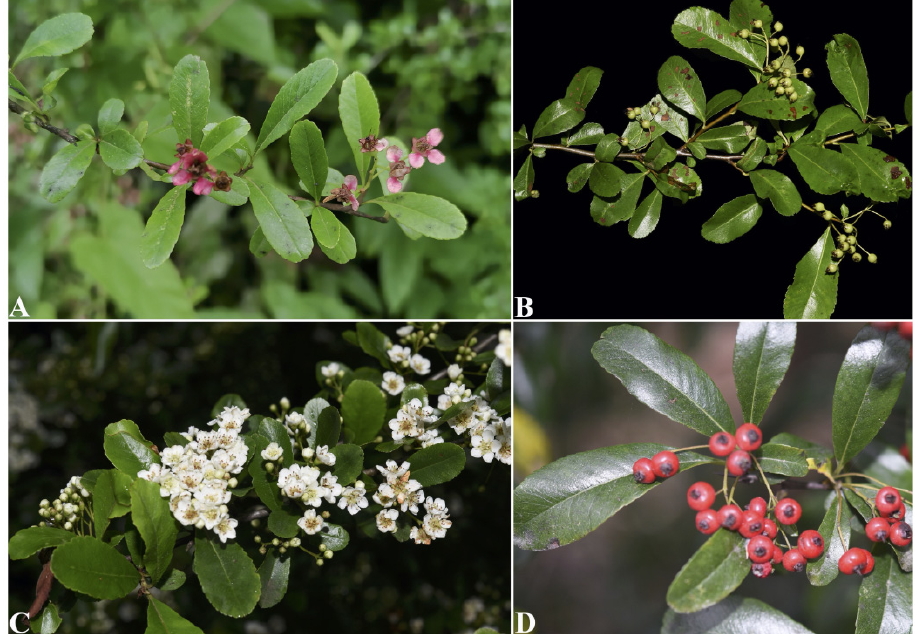
Figure 1. Morphological comparison between red and white flower phenotypes of P. fortuneana . ( A , B ) the flowers and young fruits of individual with the red flower phenotype; ( C , D ) the flowers and mature fruits of individual with the white flower phenotype (photographed by Shi-Xiong